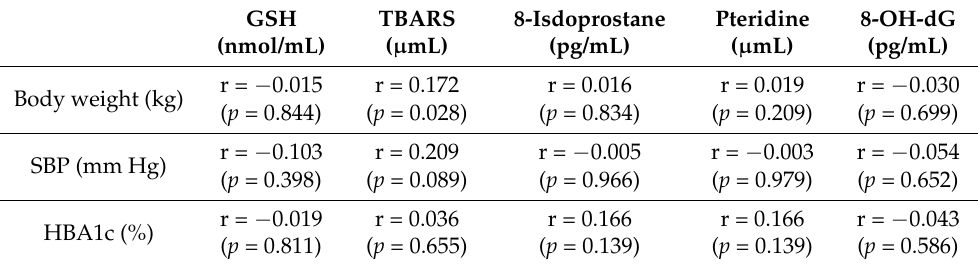
Table 4. Partial correlation between changes in metabolic risk factors and oxidative damage markers between baseline and follow-up after adjusting for